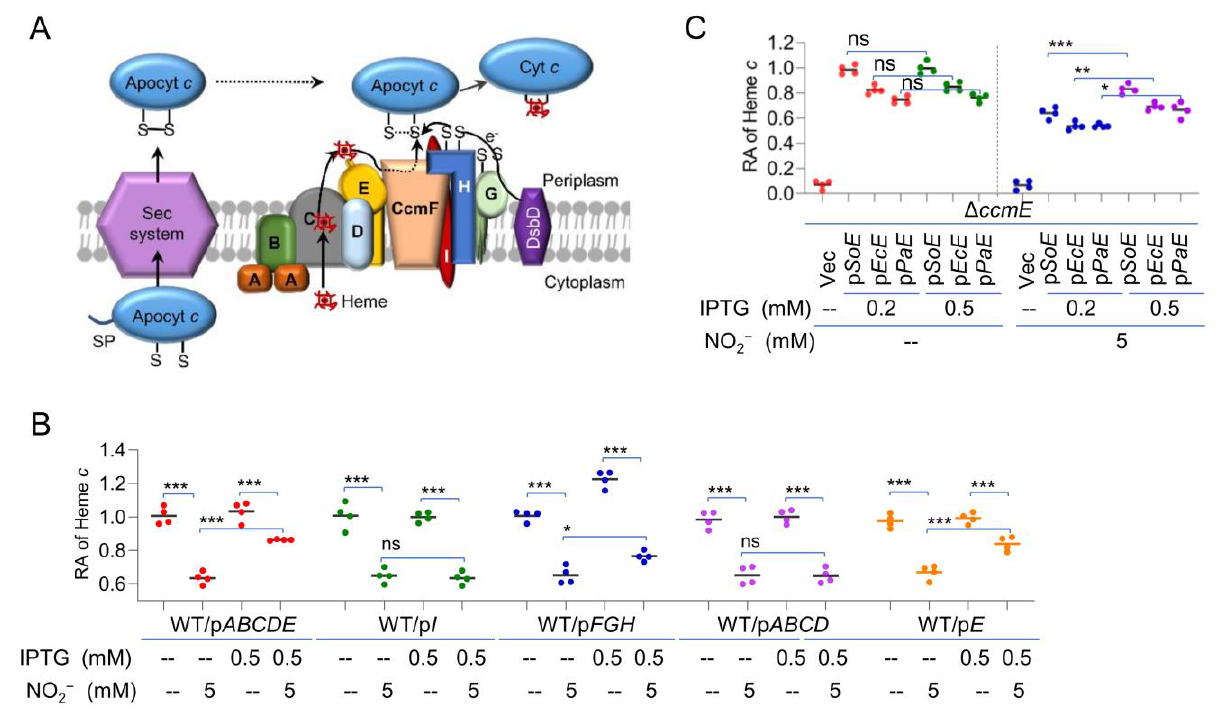
Figure 5. CcmE is a likely target of nitrite/NO in cyt c production. ( A ) A simplified model for cyt c biosynthesis in S. oneidensis . Both apocyt c and intracellular heme are transported to the periplasm, where heme attachment occurs. CcmABC transports heme across the membrane and delivers it to CcmE. CcmE then delivers heme to CcmF, which catalyzes heme attachment. ( B ) Heme c levels in WT overproducing Ccm components driven by the IPTG-inducible promoter without or with 5 mM nitrite. ( C ) Heme c levels in the ccmE mutant overproducing CcmE of S. oneidensis ( SoE ), E. coli ( EcE ), and P. aeruginosa ( PaE ) driven by the IPTG-inducible promoter without or with 5 mM nitrite. Aster- isks indicate statistically significant difference of the values compared ( n = 4; ns, not significant; *, p < 0.05; **, p < 0.01; ***, p < 0.001) .